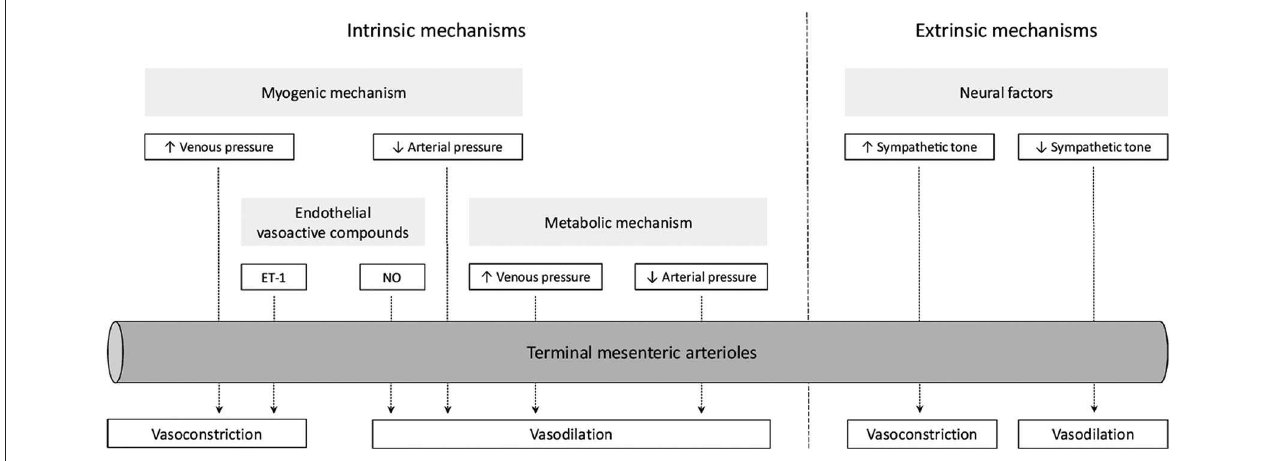
FIGURE 1 | Overview of mechanisms regulating intestinal oxygenation. ET-1, endothelin-1; NO, nitric